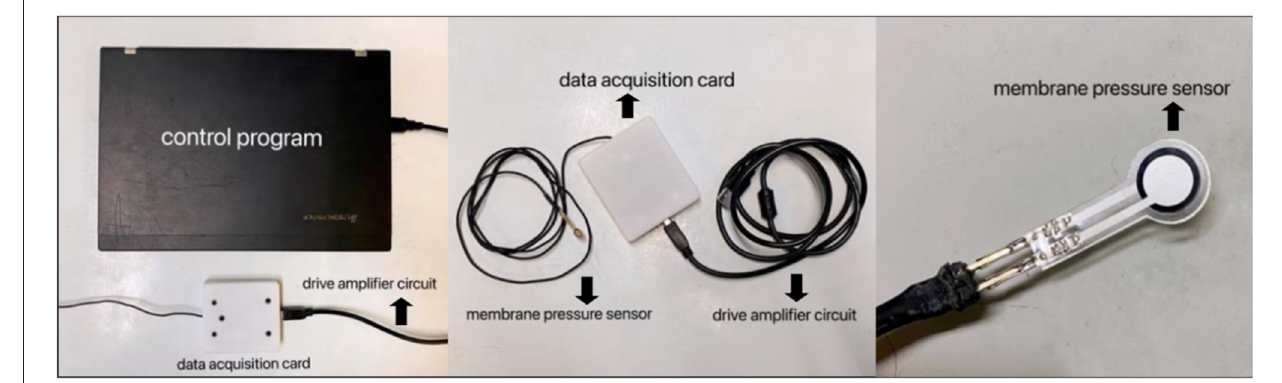
FIGURE 1 | The eyelid pressure measurement device.